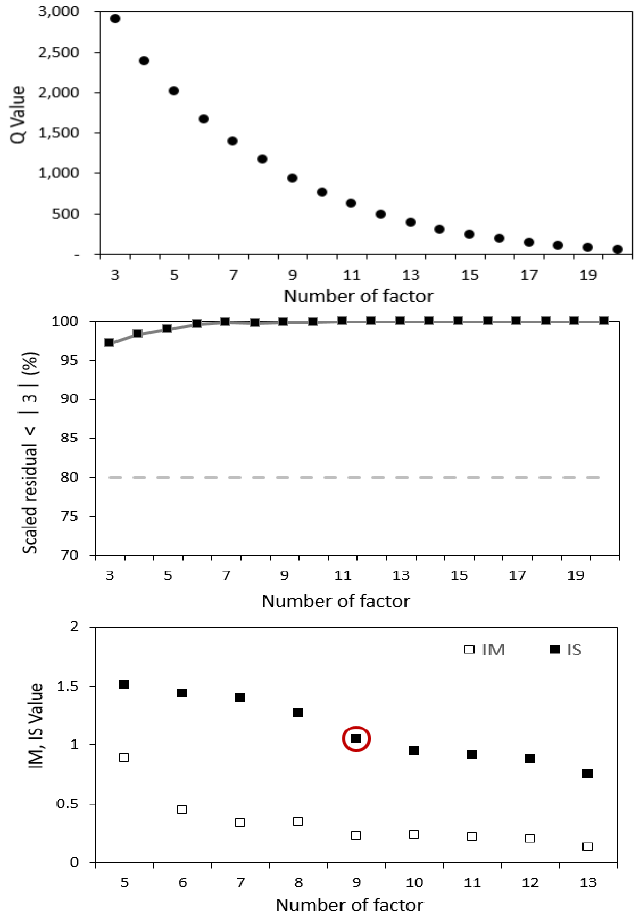
Figure 2. The Q value, scaled residual, IM, and IS for determining the number of factors.